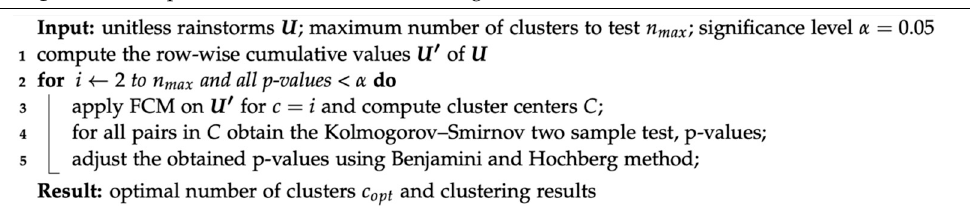
Algorithm 2: Optimal number of clusters using